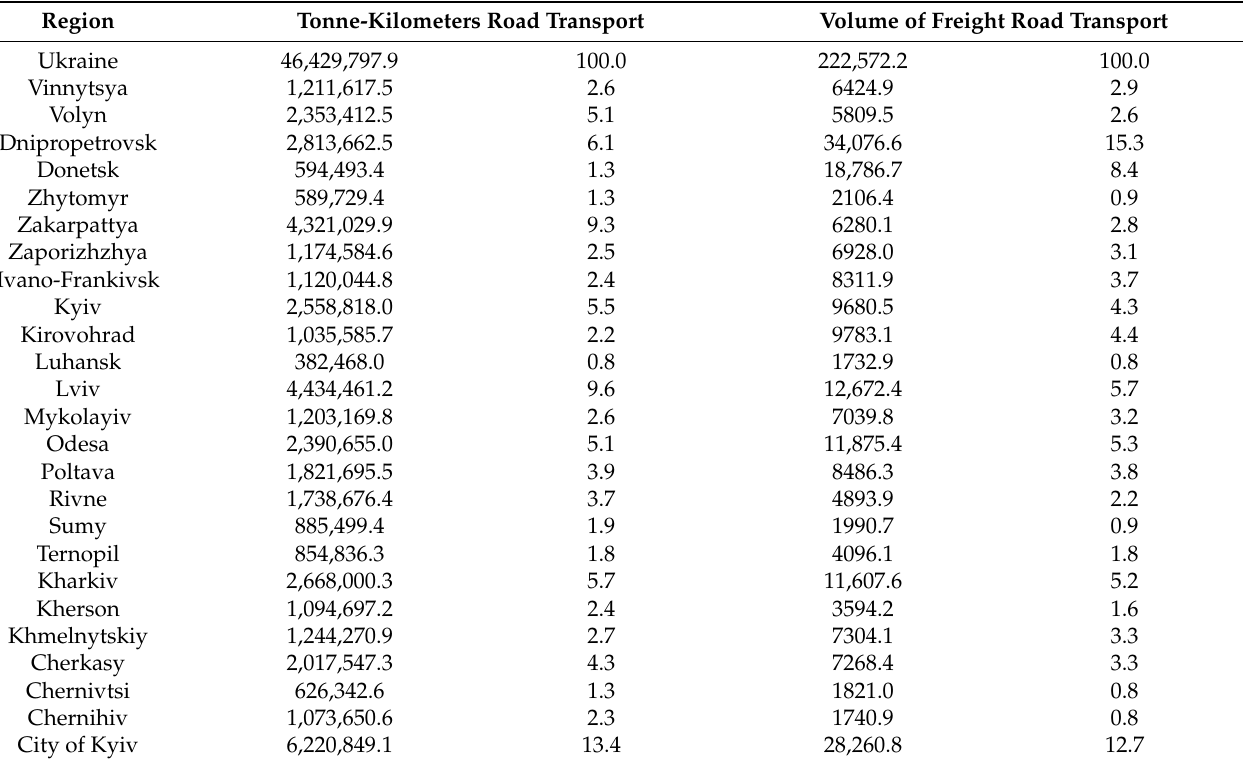
Table 4. Freight road transport by region,